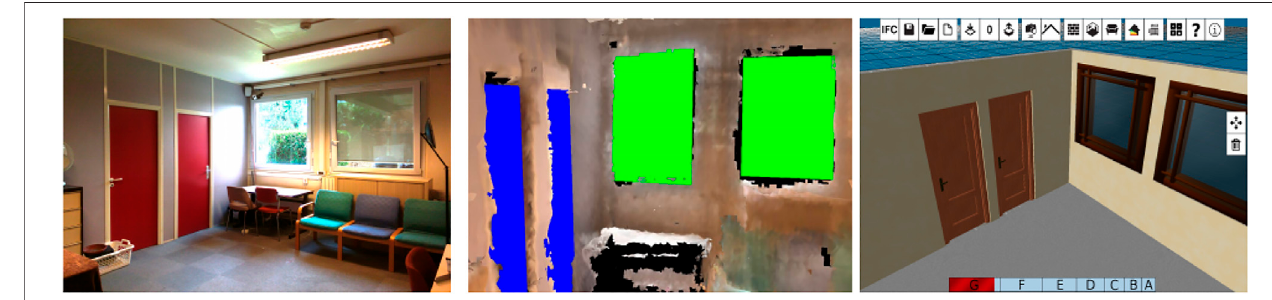
FIGURE 8 | A 3D model viewed in the software Plan 3D Energy.